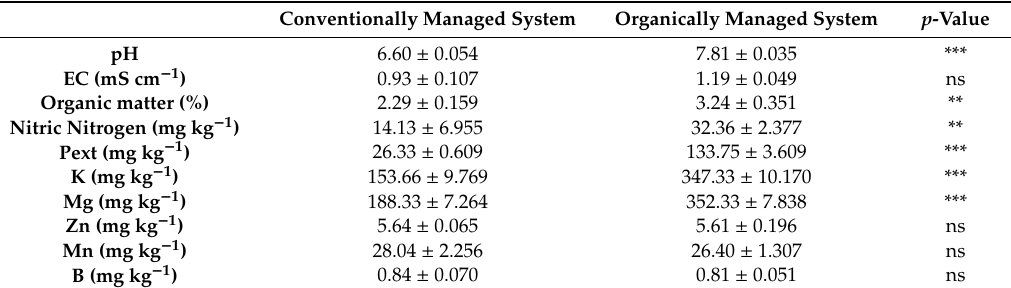
Table 1. Mean values (±SE) of the soil physicochemical variables in conventionally and organically managed systems. The independent t-test was used for the comparison of the mean values. (**: p < 0.01; ***: p < 0.001; ns: Non-significant).